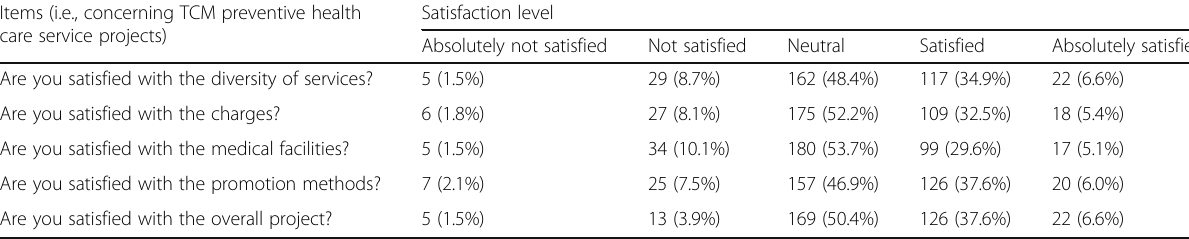
Table 5 Health care professionals ’ satisfaction levels towards TCM for prevention and health care Items (i.e., concerning TCM preventive health care service projects)